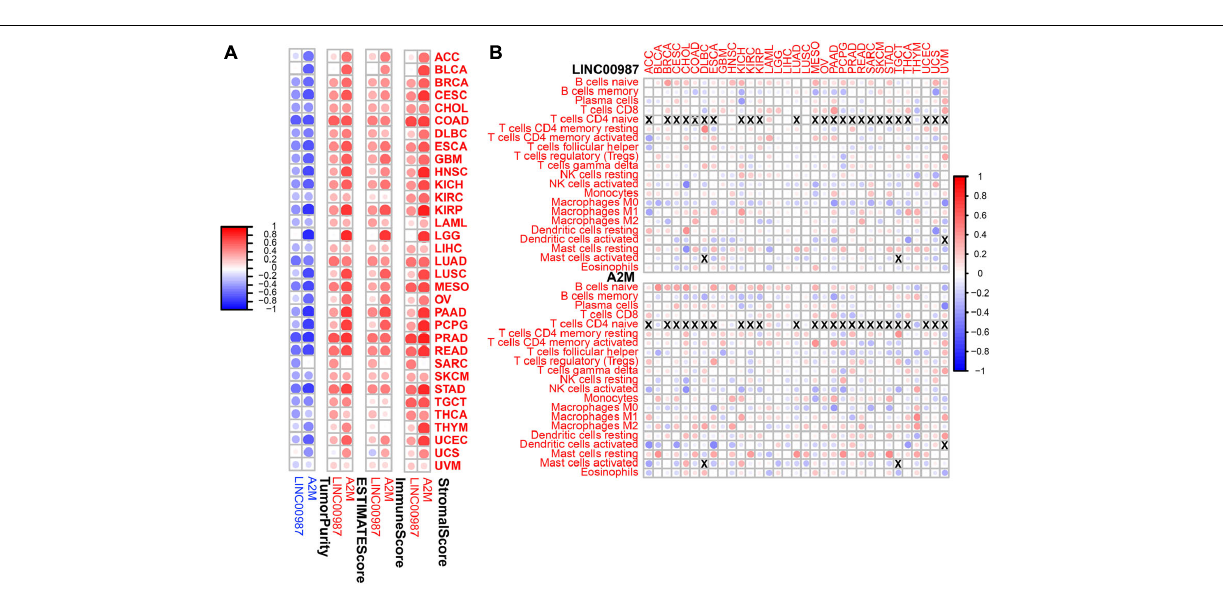
FIGURE 11 | Immune regulation according to the expression of LINC00987 and A2M in the pan-cancer analysis. (A) Correlation between the level of expression of LINC00987 and A2M and the immune score in multiple tumors determined by ESTIMATE. (B) Correlation between the expression of LINC00987/A2M and infiltration by 22 types of immune cells in pan-cancer analysis. Red indicates a correlation coefficient > 0, whereas blue indicates a correlation coefficient < 0. p <